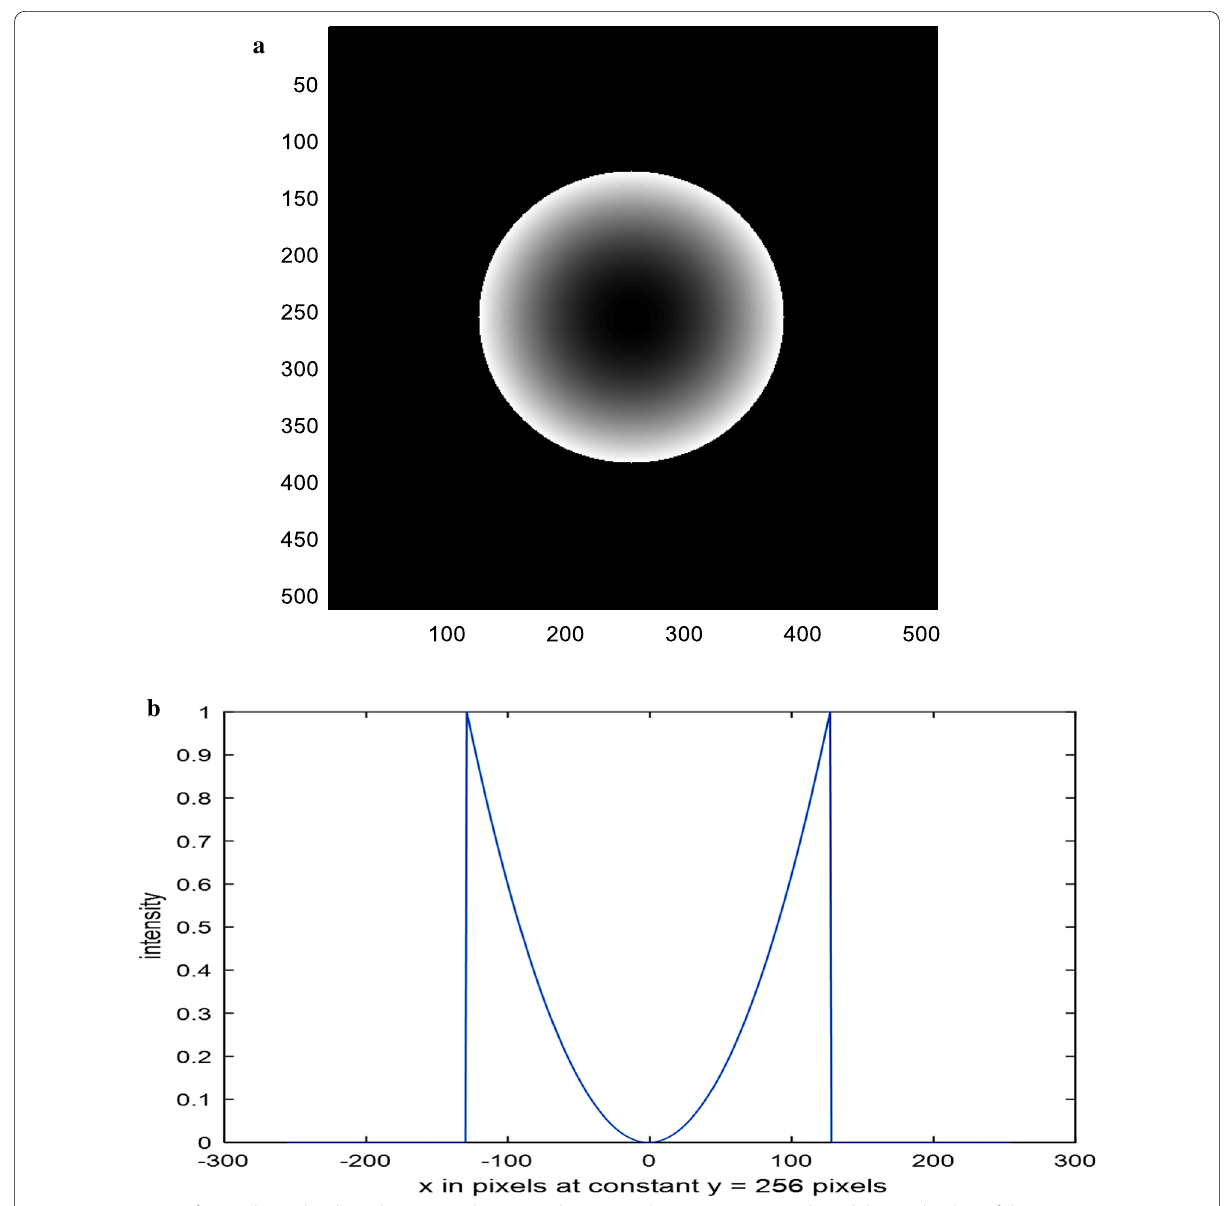
Fig. 3 a An image of a quadratic distributed aperture. The matrix dimensions have 512 pixels. b The intensity plot of the quadratic distributed aperture shown in the ( a ) at the center of the aperture at constant y